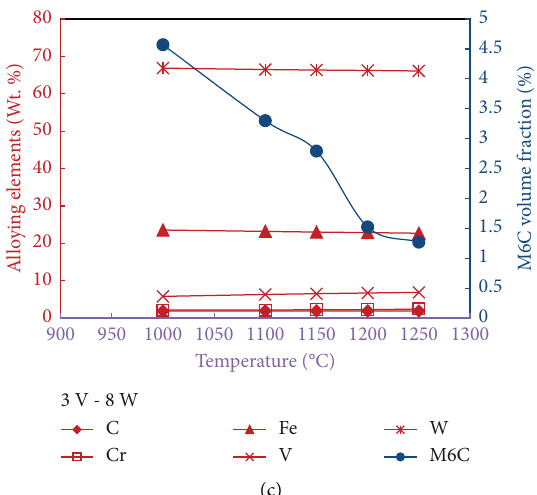
Figure 15: Chemical composition and the volume fraction of M 6 C carbide presented in vanadium-modifed steel at diferent austenitization temperatures. (a) T1 high-speed steel, (b) 2V-13W, and (c)